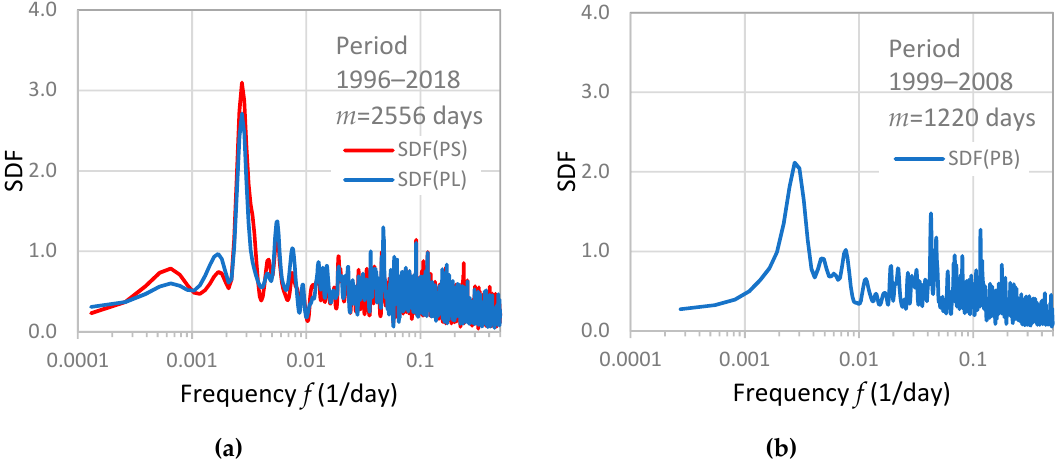
Figure 5. Spectral density function (SDF) of rainfall for: ( a ) MS Sinj (P S ) and MS Livno (P L ) for period 1996 – 2018 for truncation point m = 2556 days, and ( b ) RG Biteli ć Donji (P B ) for period 1999 – 2008 for truncation point m = 1220 days.